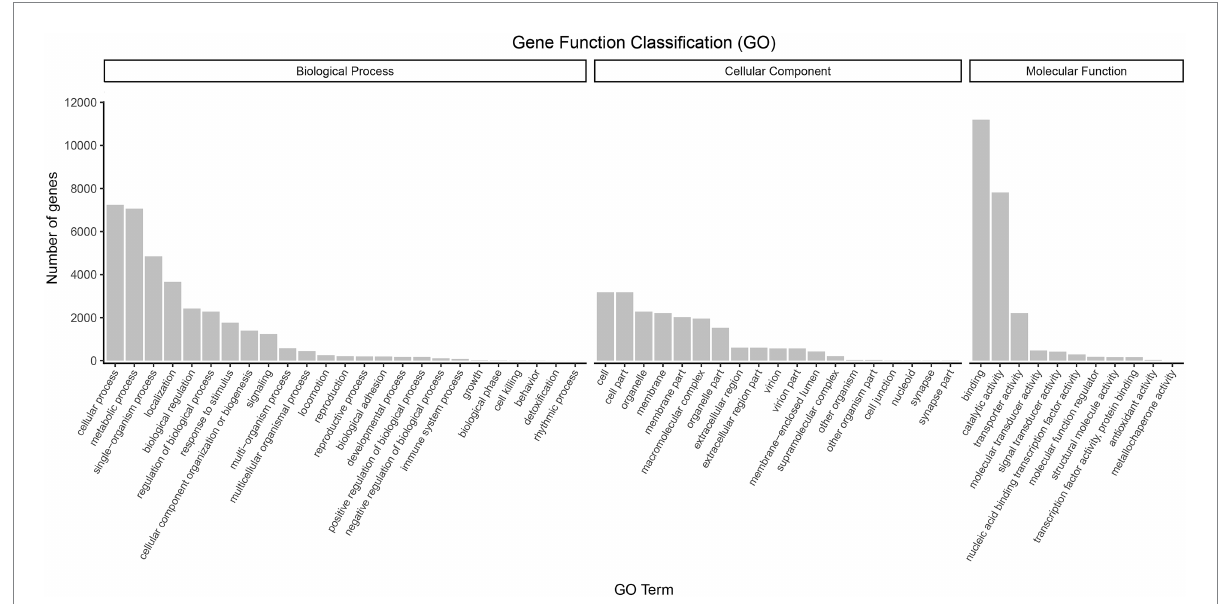
FIGURE 5 GO classification of high-quality transcripts of the A. sanguinea full-length